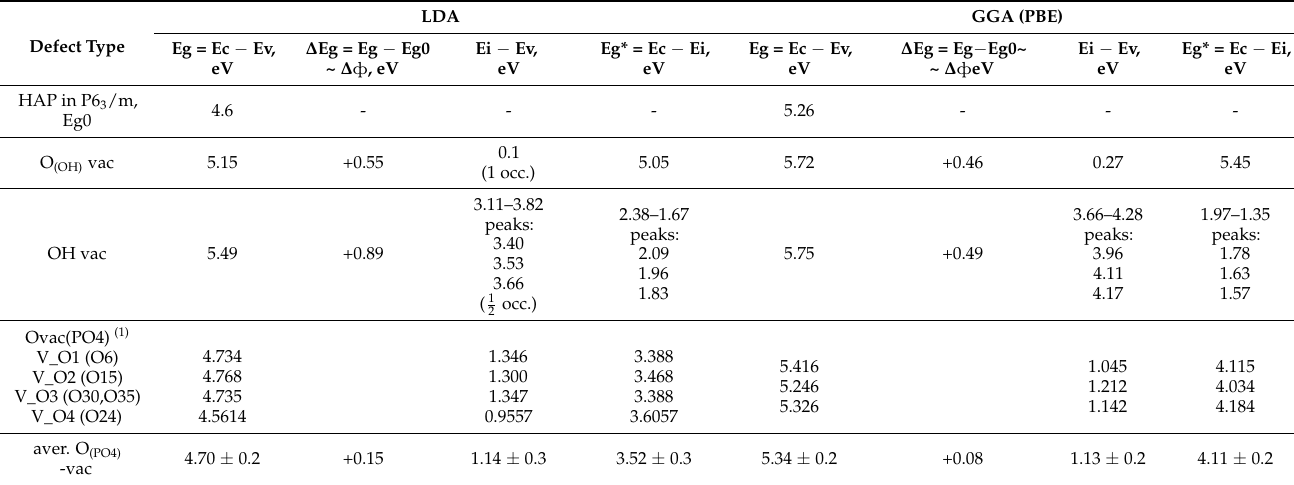
Table 4. Calculated data for HAP defects by two various approaches (aver. error = ± 0.05, ± 0.1eV) [4–6].